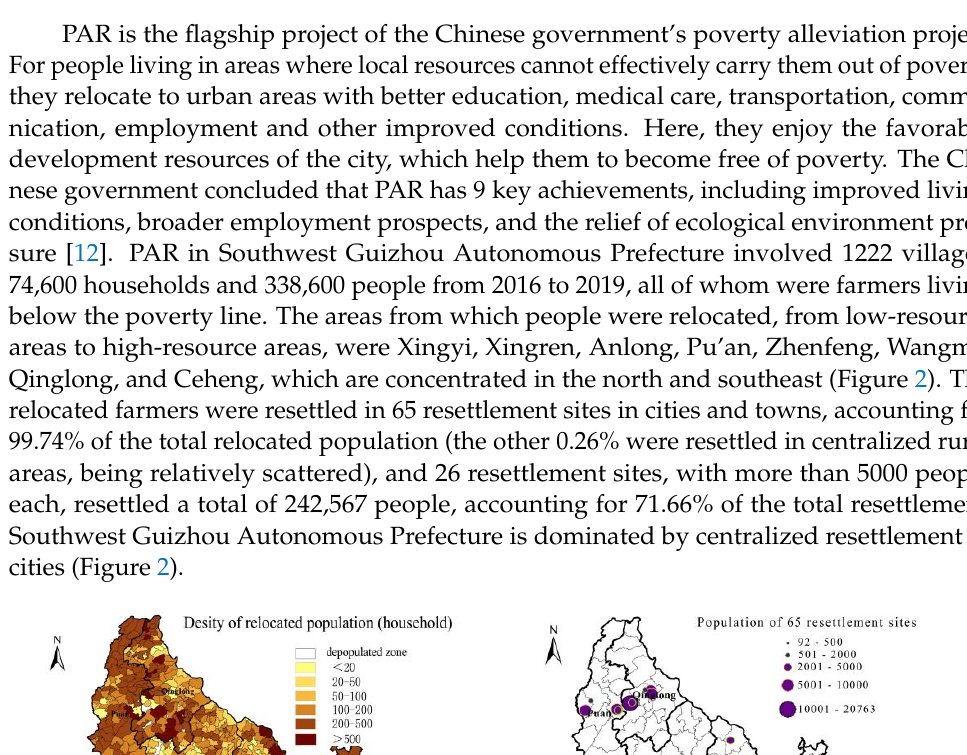
Figure 1. Distribution of degree of stone desertification in the study area.